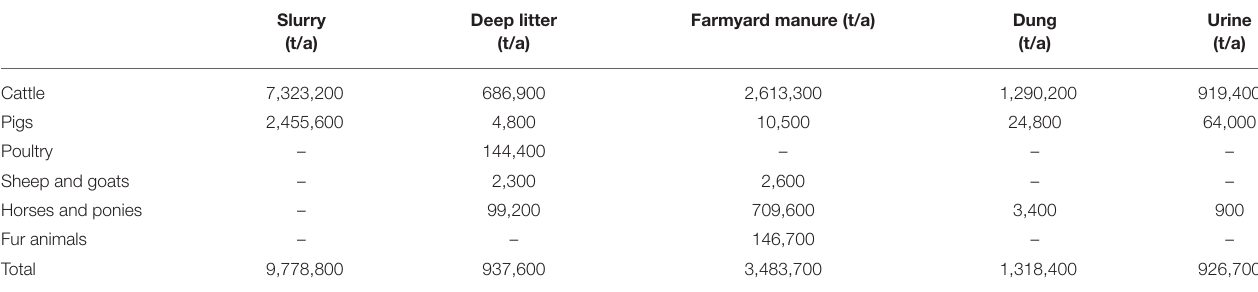
TABLE 8 | The manure quantity ex storage in Finland based on the manure data of the Finnish Normative Manure System and animal statistics of